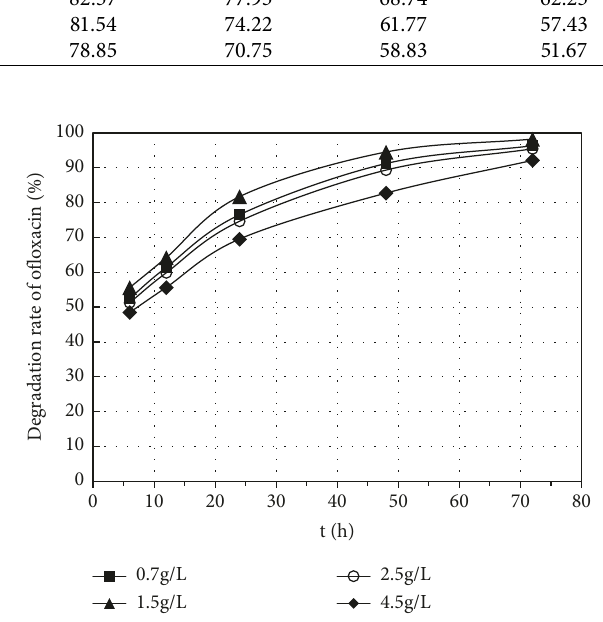
Figure 10: The effect of different Fe efficiency of